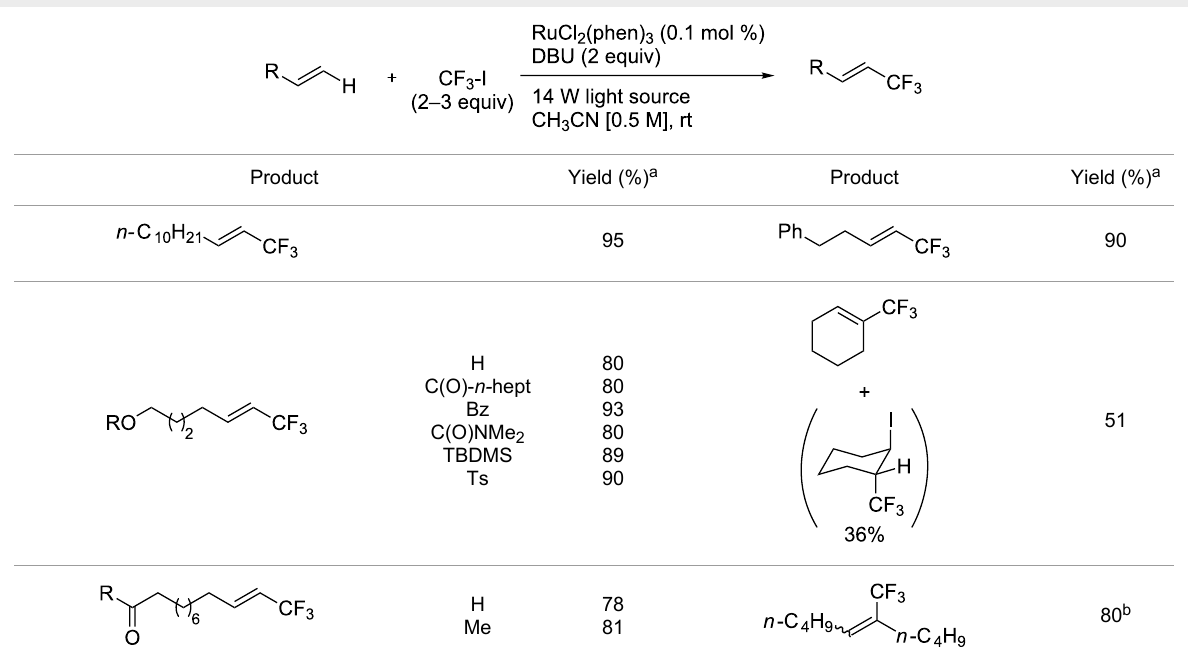
Table 32: Photoredox Ru-catalyzed trifluoromethylation of terminal and internal alkene C–H bonds with trifluoromethyl iodide